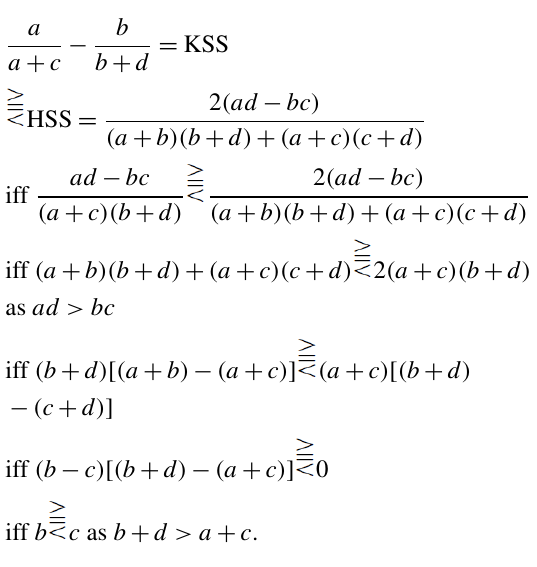
Table D1. Skill scores for binary categorical